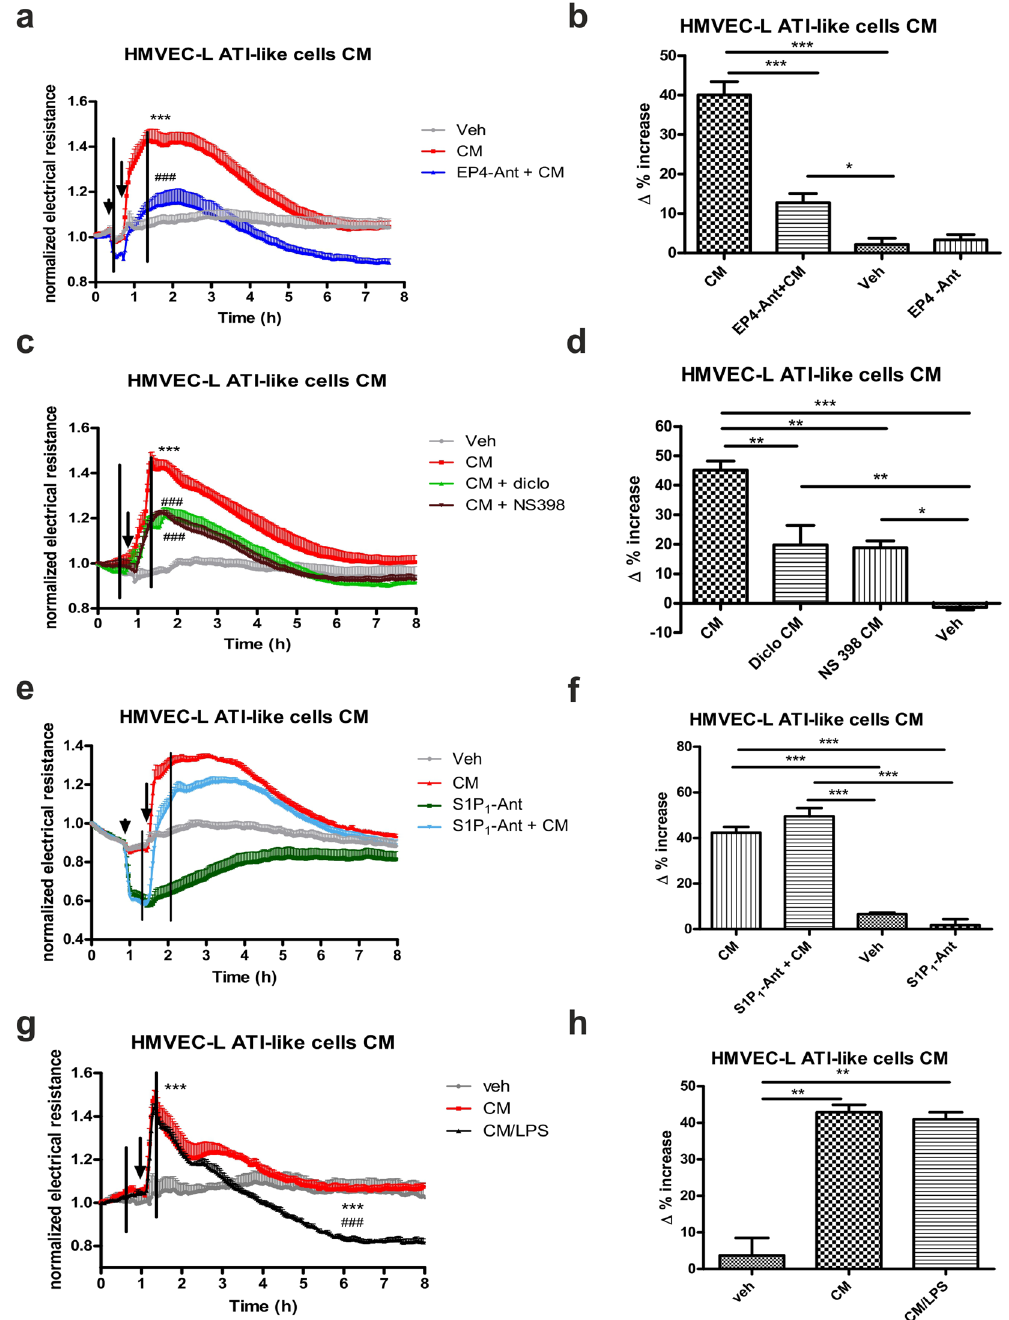
Figure 6. Conditioned medium (CM) from isolated mouse ATI-like cells increases endothelial barrier function via PGE 2 and EP4 receptors but not S1P 1 receptors. HMVEC-L were grown on gold microelectrodes and were pretreated (arrowhead) with vehicle, the ( a ) EP4 antagonist ONO AE3-208 (EP4 Ant; 300 nM) or the ( e ) S1P 1 antagonist W146 (S1P 1 -Ant; 10 µ M). CM from ATI-like cells treated with ( a – f ) vehicle, ( c , d ) diclofenac (diclo 10 µ M), NS398 (1 µ M) and ( g , h ) LPS (10 µ g/ml) or corresponding medium (Veh) was added (indicated by arrows). To detect differences in barrier function (measured as change in resistance), Δ % values were calculated. The black lines mark the time points which were used to calculate Δ % increase shown in ( b,d,f,h ). ( a,c,e,g ): data show mean normalized resistance + SEMs; ( b,d,f,h ): Δ % increase was calculated by subtracting normalized resistance of the first time point marked in ( a,c,e ) or ( g ) from the second time point, and multiplying the value with 100. Statistical analysis was performed using two-way ANOVA and Tukey’s multiple comparison test for ( a,c,e ) and ( g ) and one-way ANOVA followed by Bonferroni’s post hoc test for ( b,d,f ) and ( h ); n = 5, * p < 0.05; ** p < 0.01; *** p < 0.001; * vs vehicle; # vs CM